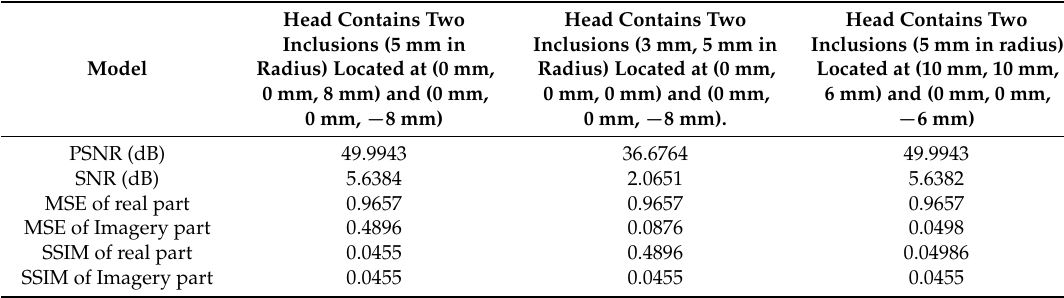
Table 2. Simulation errors .